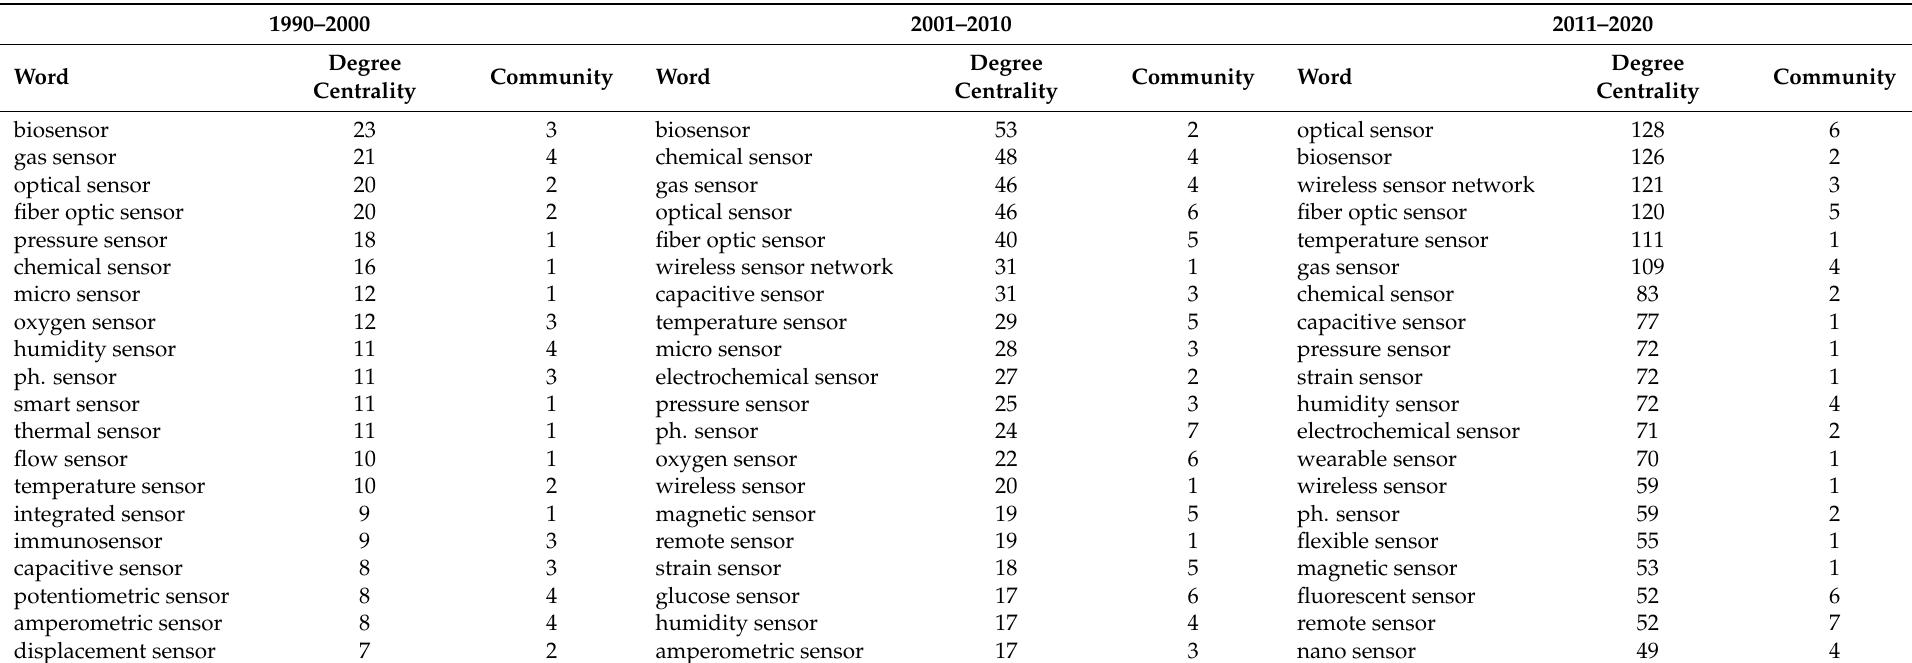
Table 1. Top 20 units of sensor in networks having the highest centrality degree during the 1990–2020